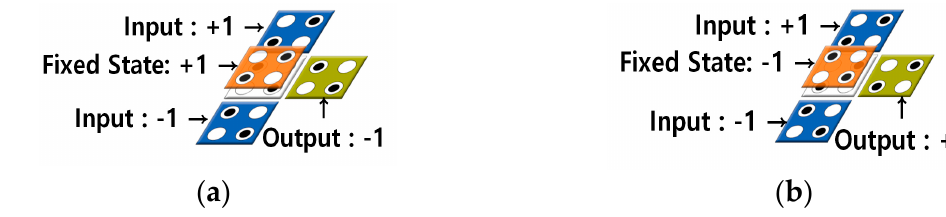
Figure 4. Multilayer based AND/OR gate: ( a ) AND gate, ( b ) OR gate.